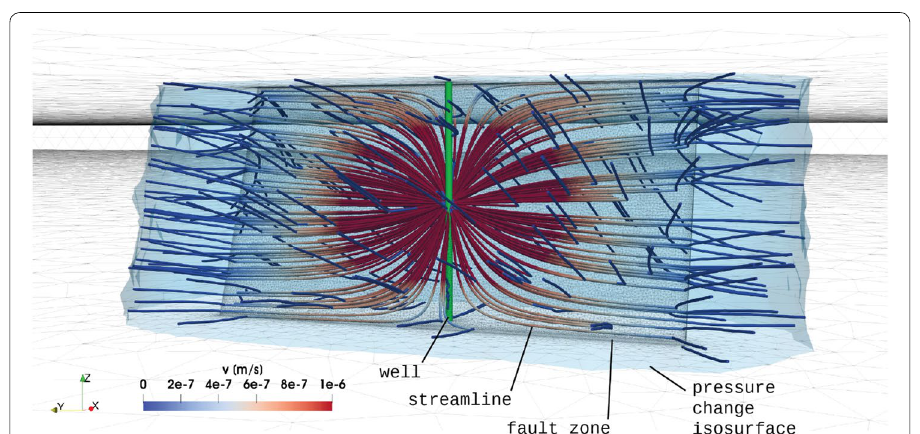
Fig. 4 Example flow field of the numerical model with linear flow behavior, streamlines colorized after the flow velocity (v), induced pressure change as blue transparent